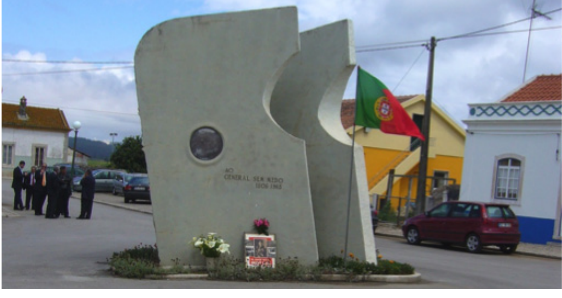
FIGURE 18 | J. Aurélio, Monument to the Fearless General, 1976, civic site, Cela Velha.